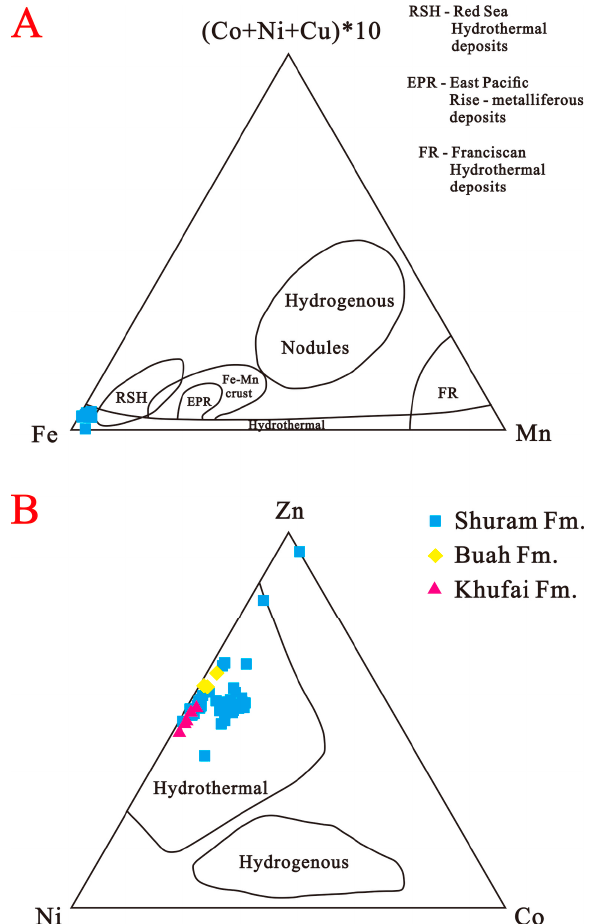
Figure 4. Discriminant diagrams of sediments with the hydrothermal origin. ( A ) Modified after [59–61]; ( B ) modified after [62].